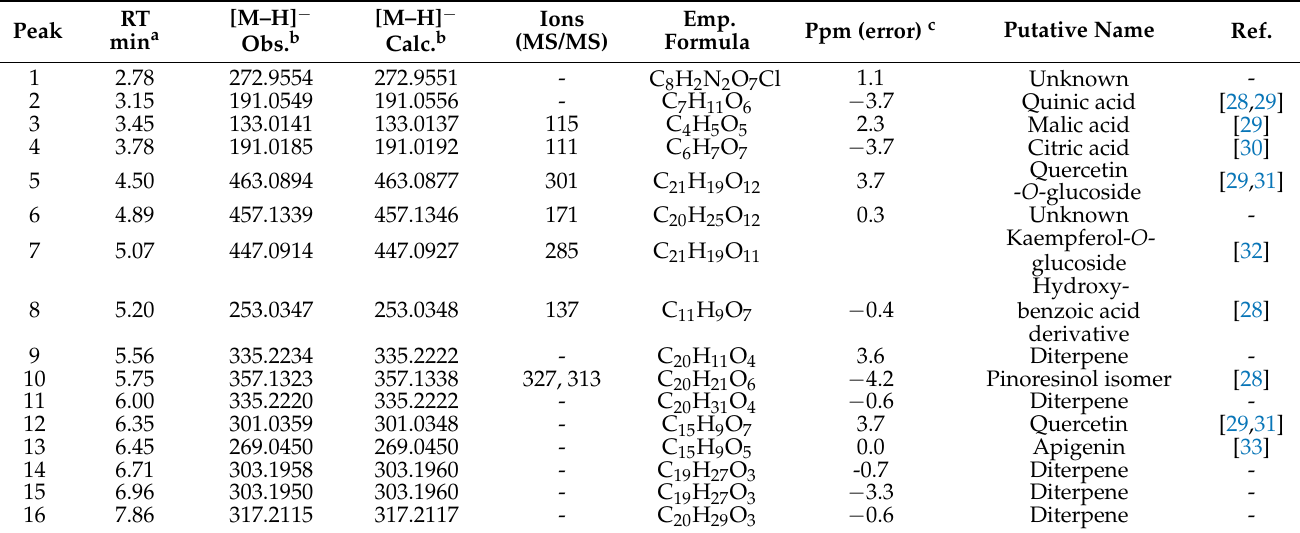
Table 2. Compounds identified in the aqueous extract of Croton heliotropiifolius roots in the negative mode. Peak